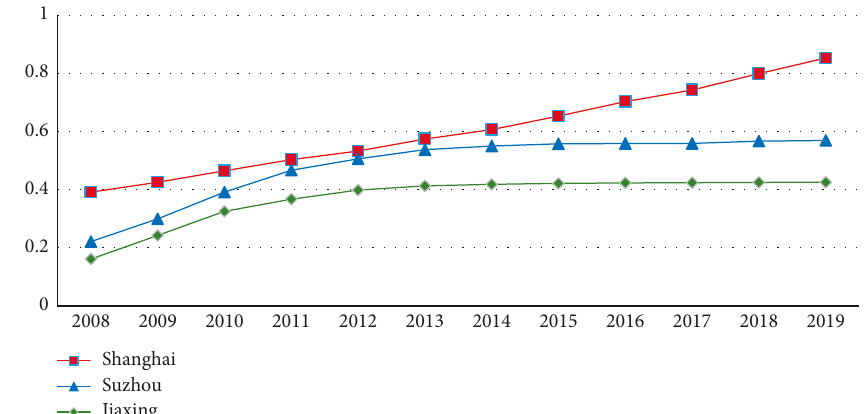
Figure 1: Time trend of comprehensive innovation development levels. Note. Data are from the China Science and Technology Statistical Yearbook, China Statistical Yearbook, China High and New Technology Industry Statistical Yearbook, Shanghai Statistical Yearbook, Suzhou Statistical Yearbook, Jiaxing Statistical Yearbook, China City Database, WIEGO Statistical Database, websites of Science and Technology Bureau and Statistics Bureau, and government work reports from 2008 to 2019. The descriptive statistics of all indicator data are shown in Table 4.